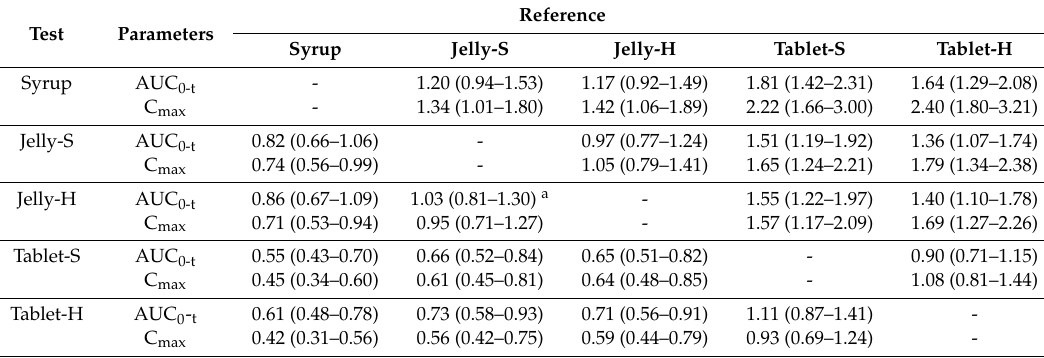
Table 7. Point estimates of mean ratio (90% confidence intervals) for DMH.